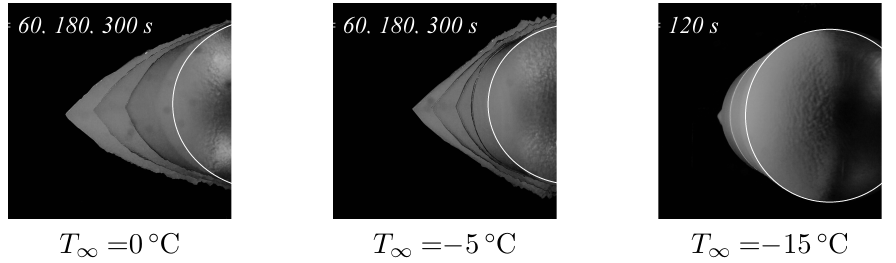
Figure 31. Side view of ice accretion shapes on a cylinder for TWC = 12gm − 3 , m r = 0 . 12 and U ∞ = 40ms − 1 with a variation of temper- ature.